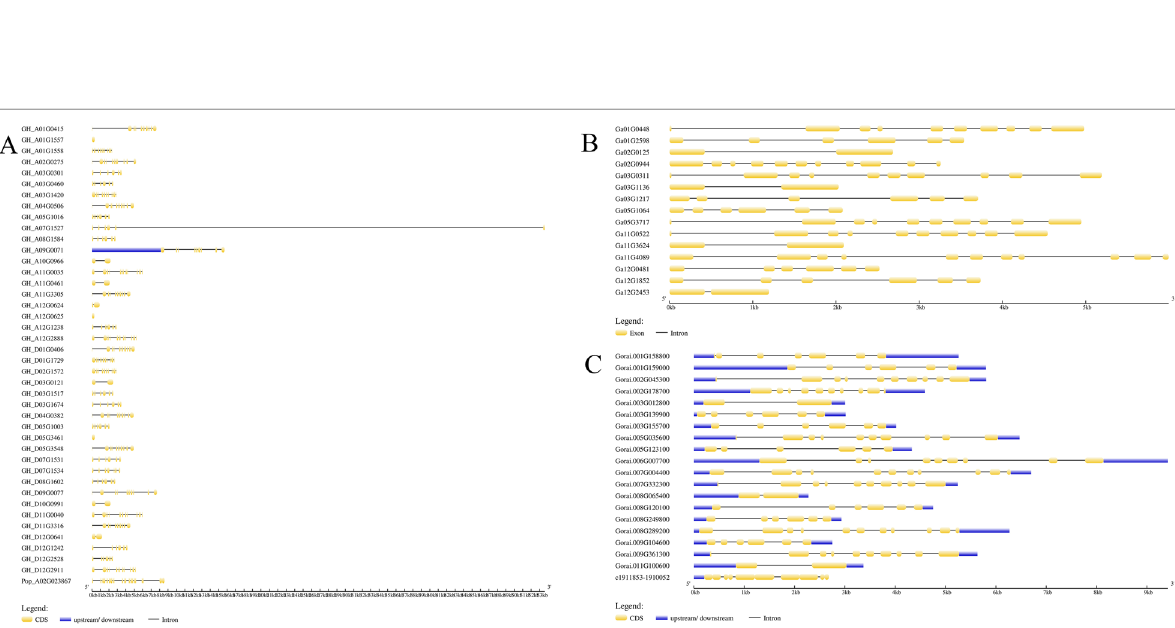
Fig. 4 Analysis of gene structure using gene structure display server. A ) Gossypium hirsutum ; B ) Gossypium arboreum ; and C ) Gossypium